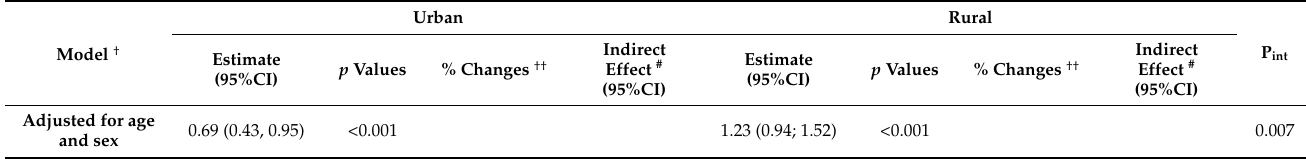
Figure 3. Changes of calorie-, fat-, protein-, and carbohydrate intake in urban and rural subjects after 1-year of living in an urban environment. The changes are presented as estimate and 95% confidence interval (95%CI). The changes in each group and the differences of changes between urban and rural group for each parameter were analyzed using a linear-mixed model, adjusted for age and sex. The p -value depicted in the figure represents the p -value for interaction (P int ), the level of significance in the differences of changes between the two groups. * p < 0.05. Table 3. Mediation analysis of the effect of changes in dietary intake and physical activity over time on the changes of BMI at 1-year follow-up in both urban and rural